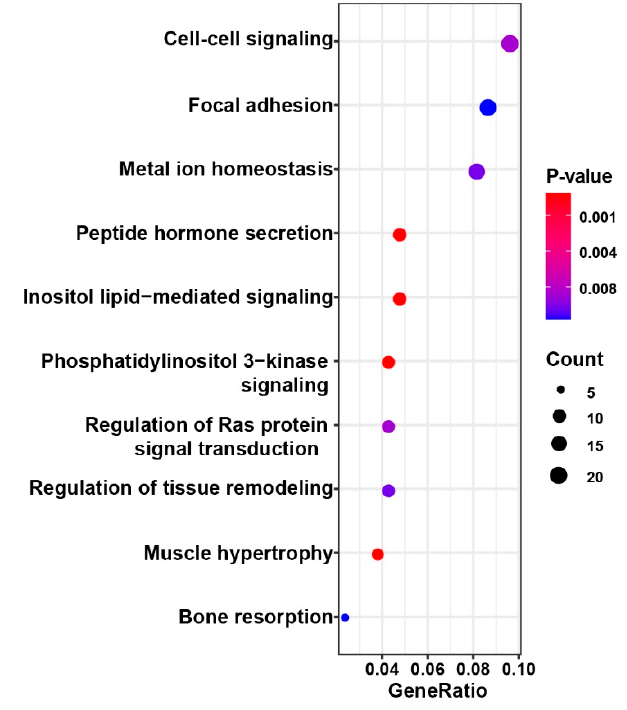
Figure 4. Enrichment analysis of functional genes affected by polymorphic SSRs. Table 3. Summary information of functional SSRs (SSLP ≥ 2) and associated genes.